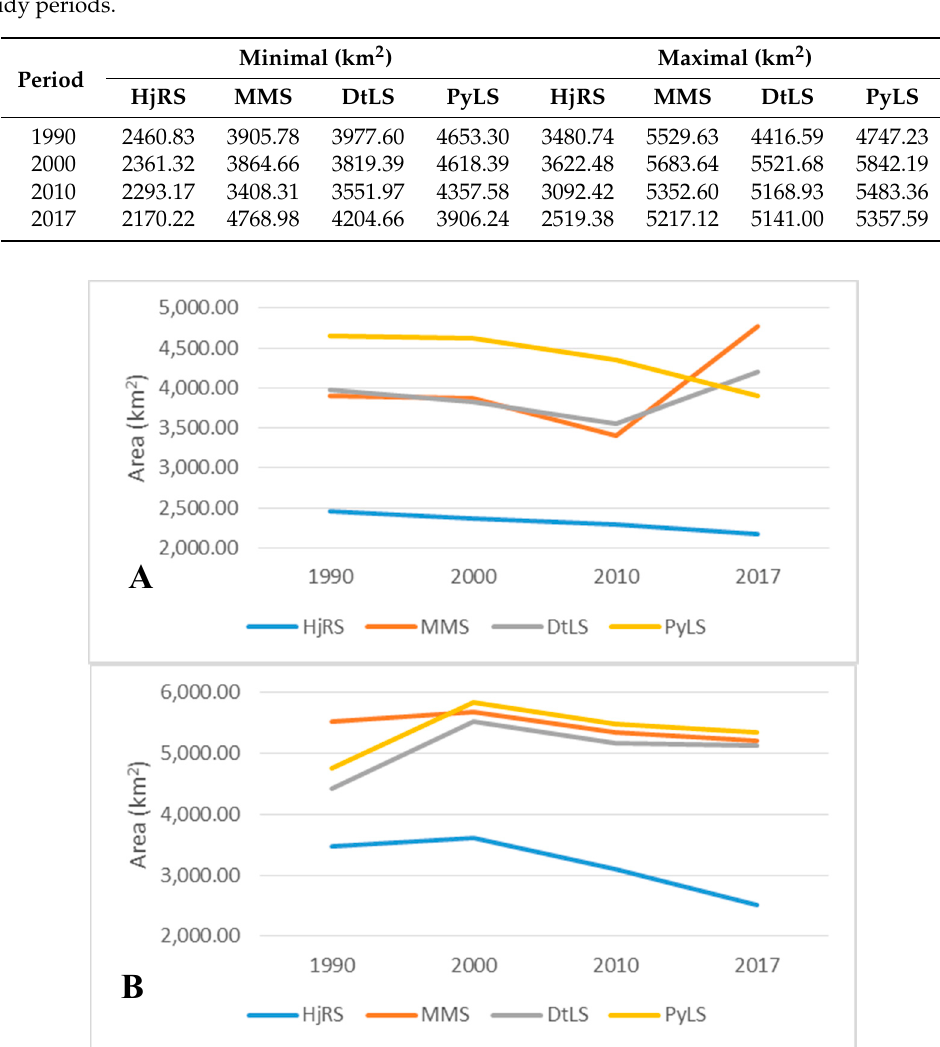
Table 4. Areas and change rates of large surface water and others of minimal and maximal surface water extent in the study periods.